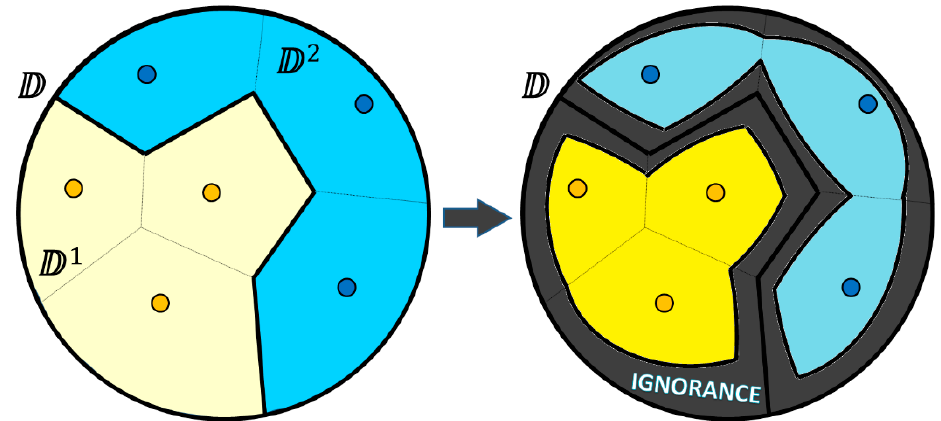
Figure 12. Ignorance-aware Voronoi diagram creation with two homogeneous clusters of data points: (on the left) the Voronoi cells with the same class label are merged into two subdomains separated by the decision boundary; (on the right) the ignorance zones are computed separately for each of two subdomains and merged into the ignorance area around the homogeneous groups of points, leaving also some space for two zones of believed certainty.